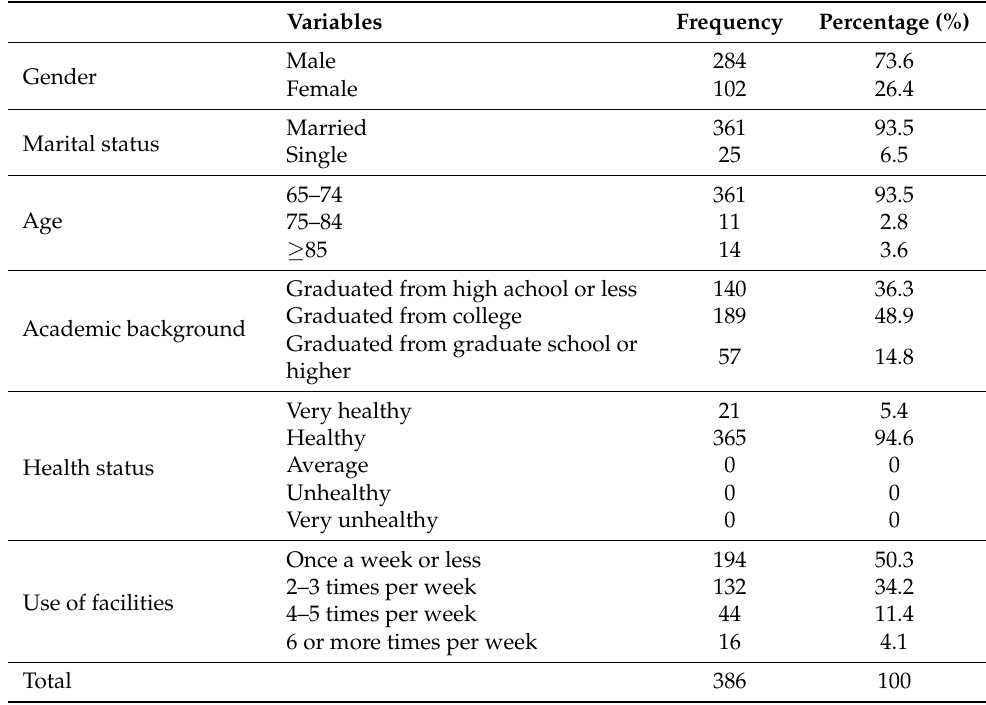
Table 3. Demographic characteristics of the respondents.